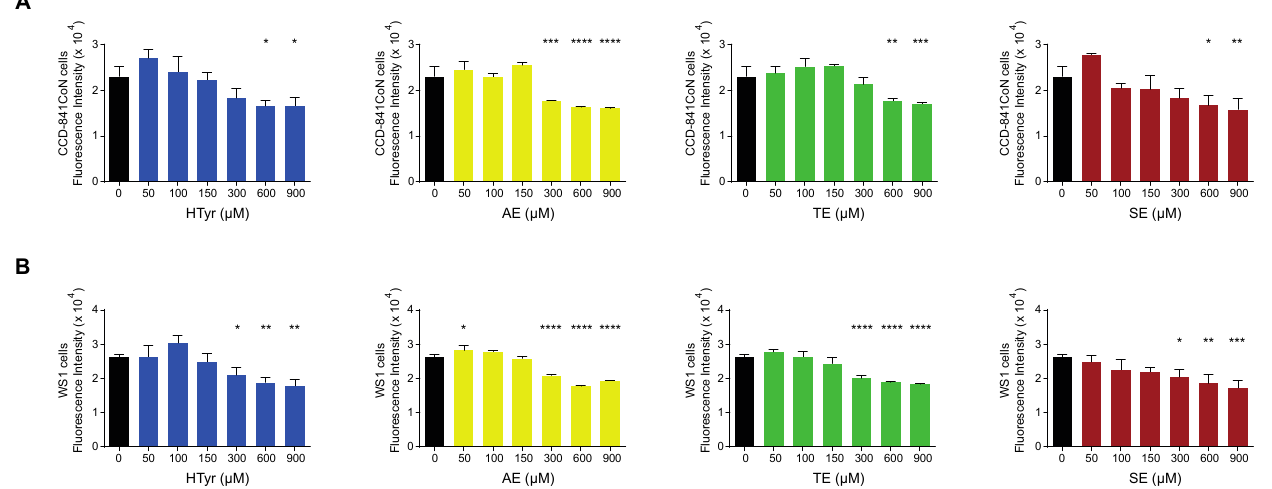
Figure 3. Normal cells viability exposed to hydroxytyrosol and OPWPs extracts: ( A ) Cell viability of CCD-841CoN normal colon cells exposed to increasing doses of HTyr or OPWPs extracts (from 0 to 900 μ M) for 72 h assessed by fluorescence intensity and reported as histograms. ( B ) Cell viability of WS1 normal fibroblasts exposed to increasing doses of HTyr or OPWPs extracts (from 0 to 900 μ M) for 72 h assessed by fluorescence intensity and reported as histograms. Statistical significance is considered when * p ≤ 0.05, ** p ≤ 0.01, *** p ≤ 0.001, **** p ≤ 0.0001 (ANOVA with Dunnett’s post-test).